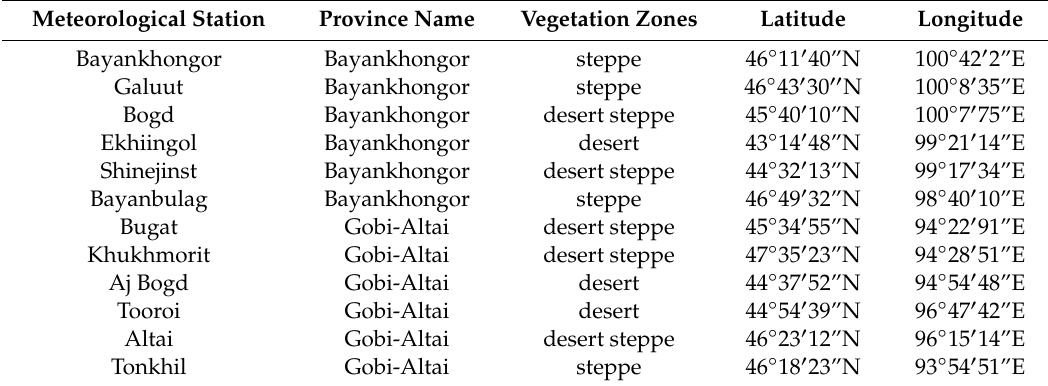
Table 2. Meteorological stations with information on location, and vegetation zones.